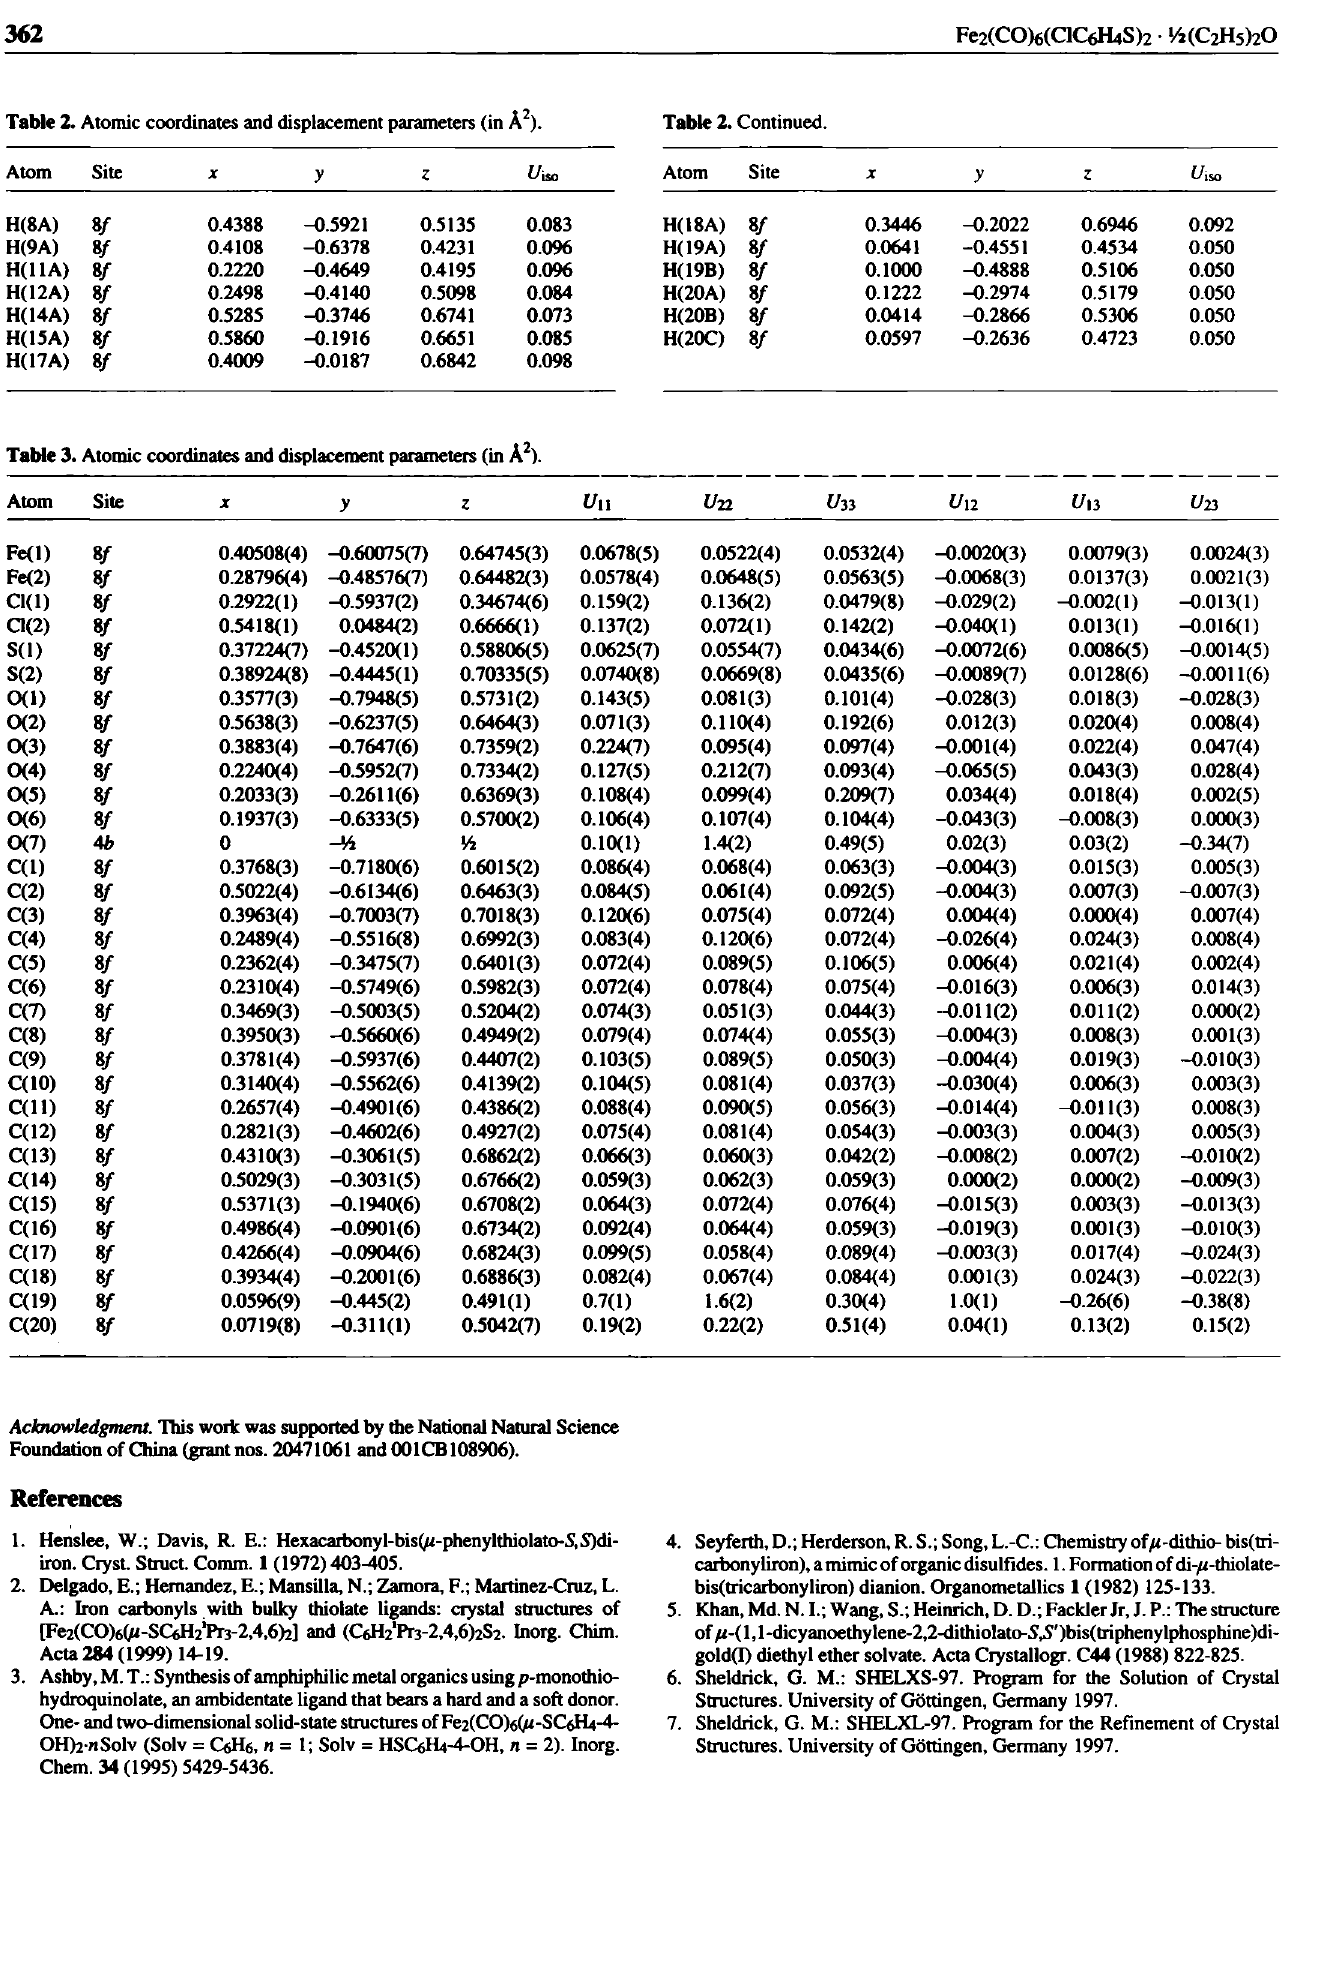
Table 3. Atomic coordinates and displacement parameters (in A 2